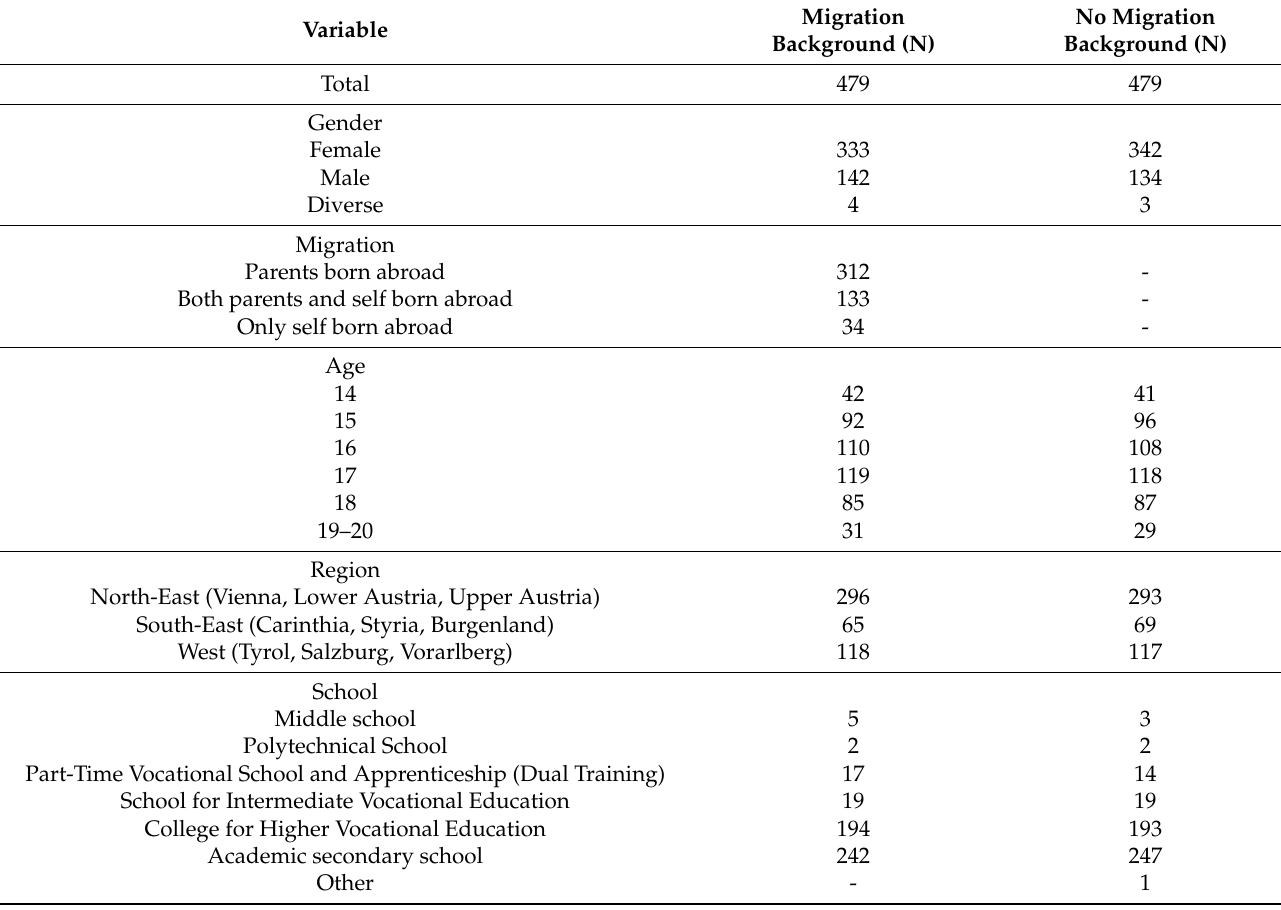
Table 1. Matched sample characteristics (N =